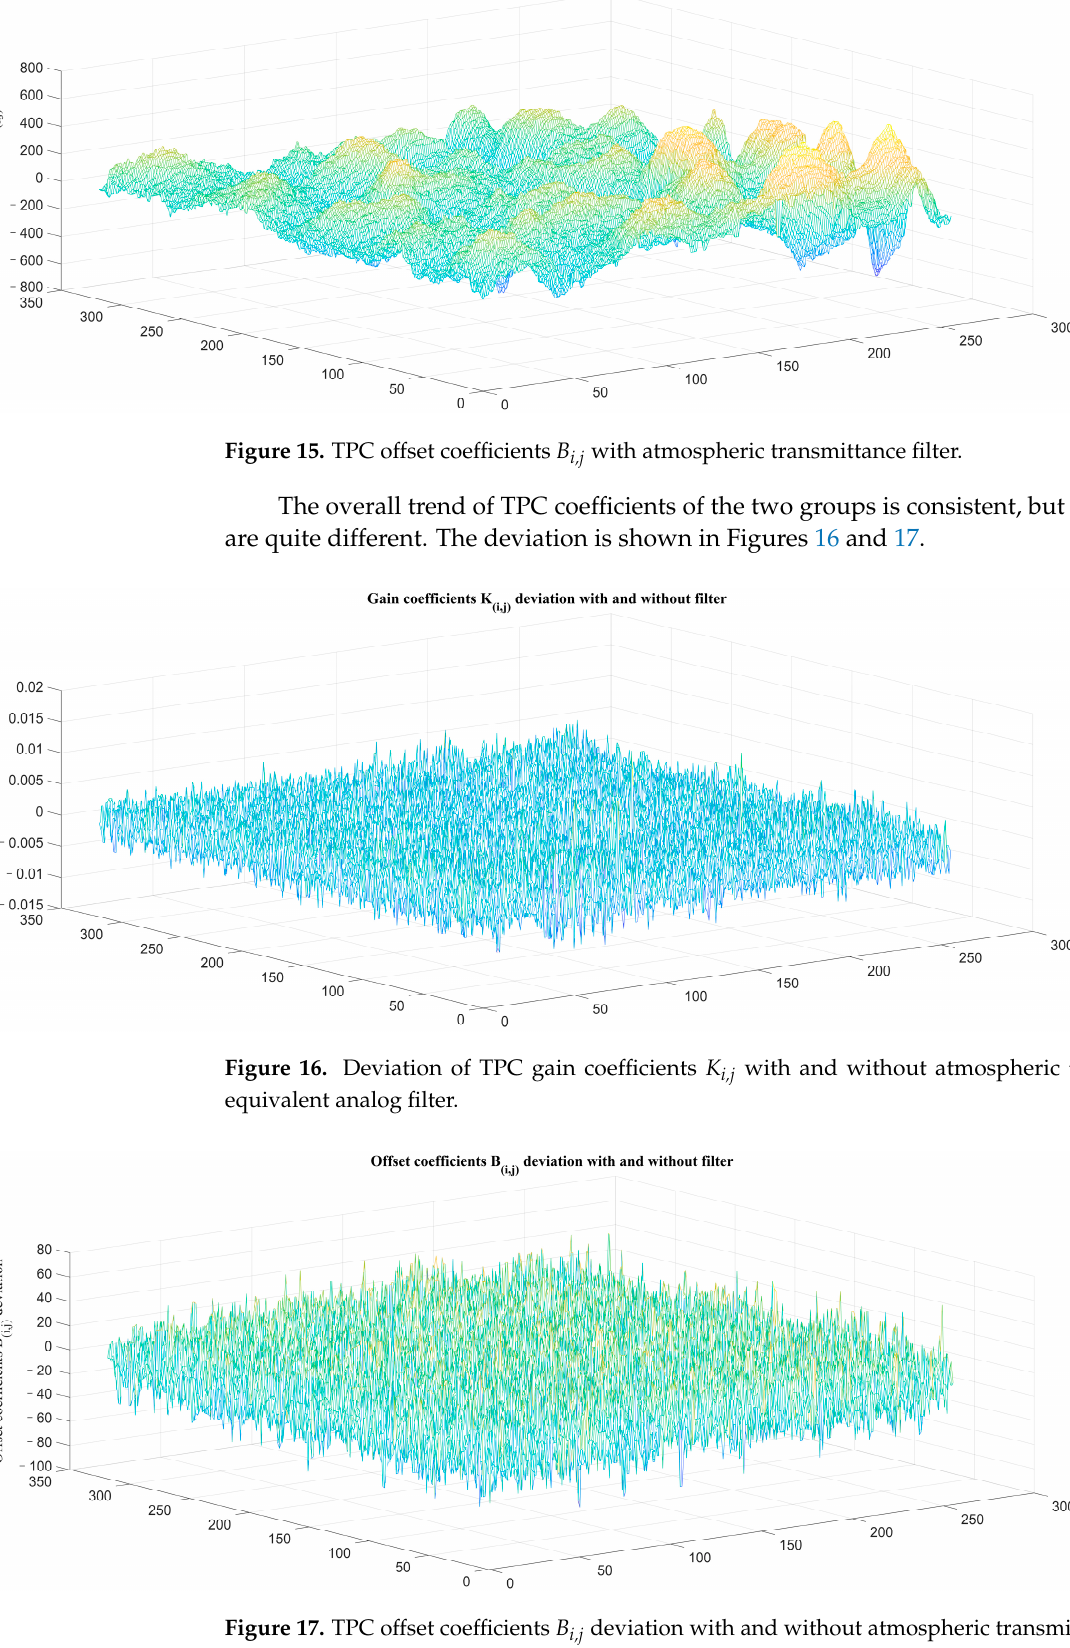
Figure 17. TPC offset coefficients B i,j deviation with and without atmospheric transmittance equiva- lent analog